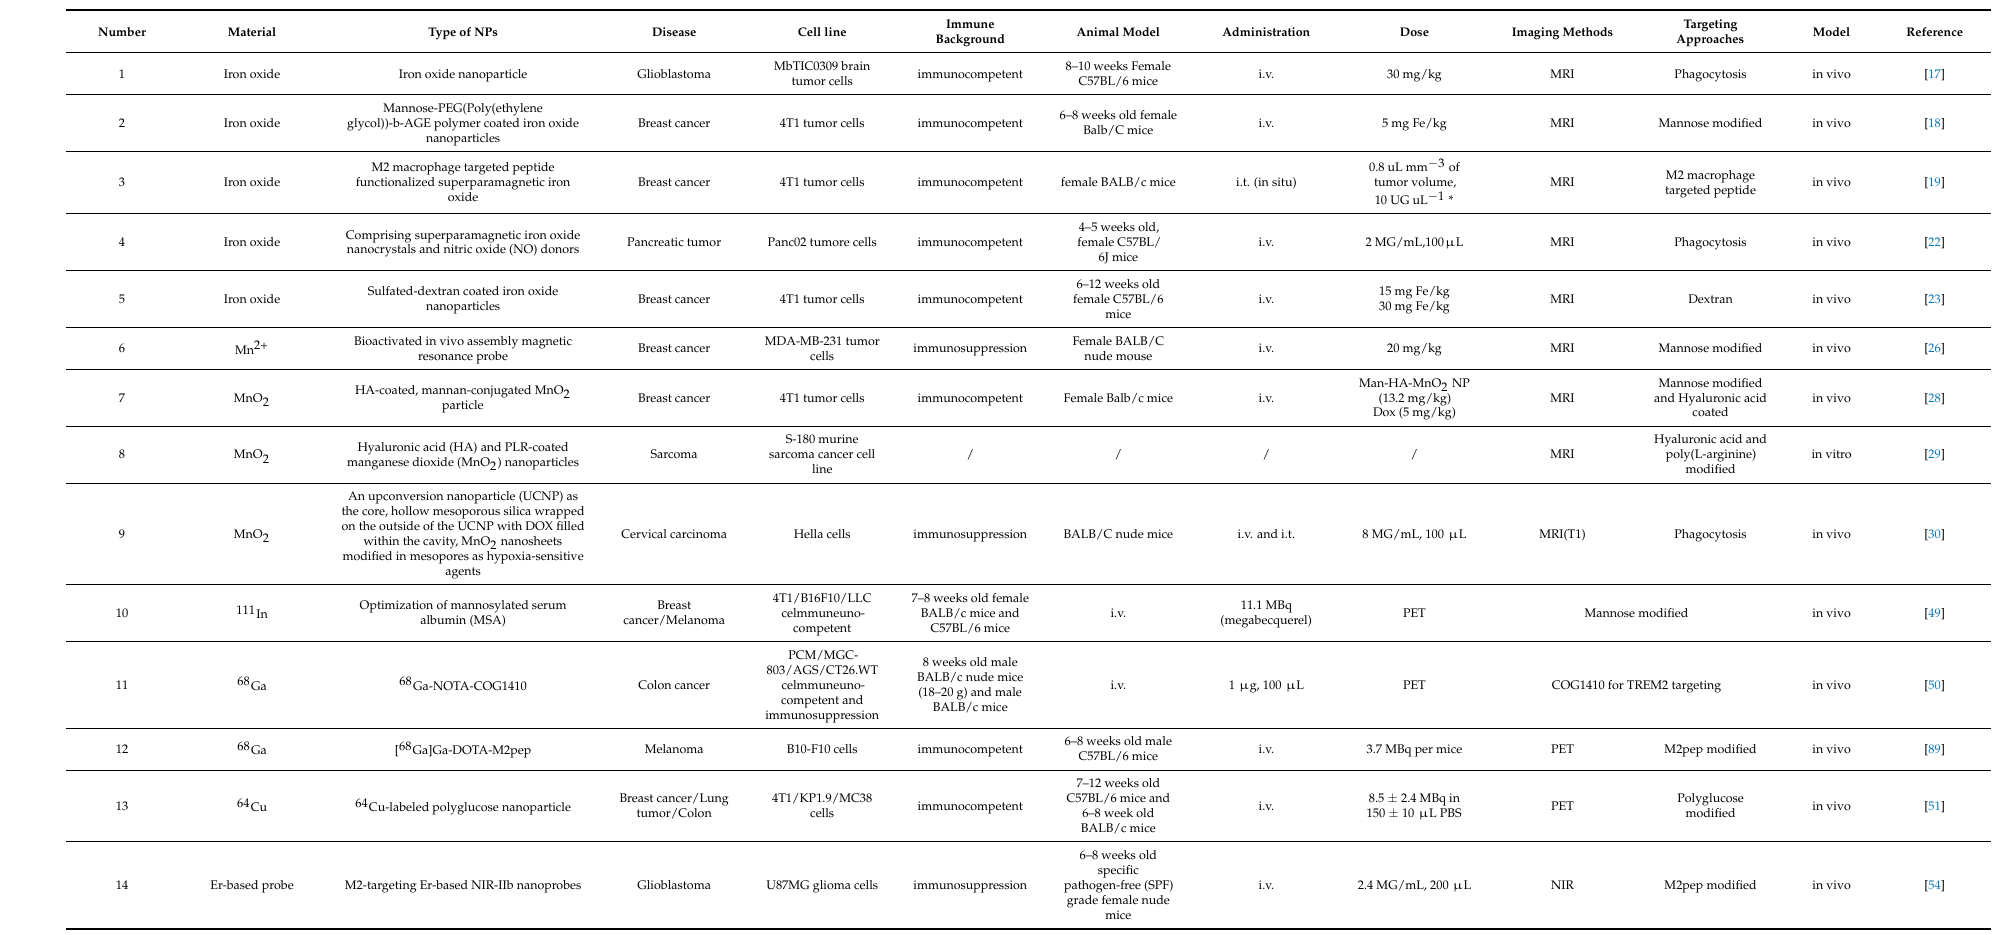
Table 1. Nanoplatforms for imaging